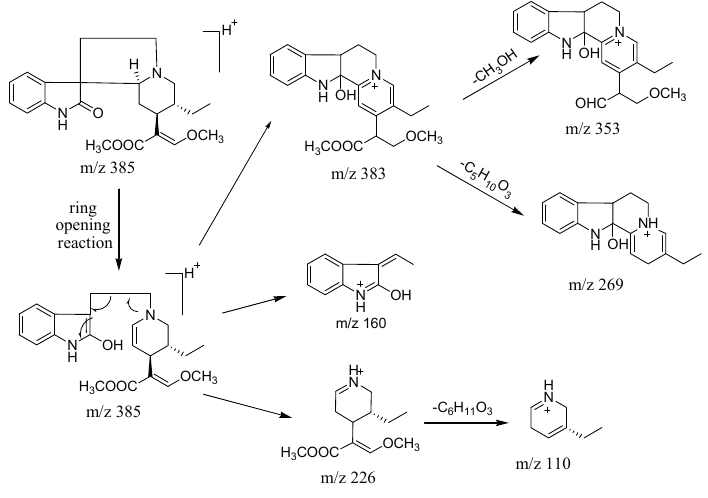
Figure 5. The proposed fragmentations pathways of RIN and